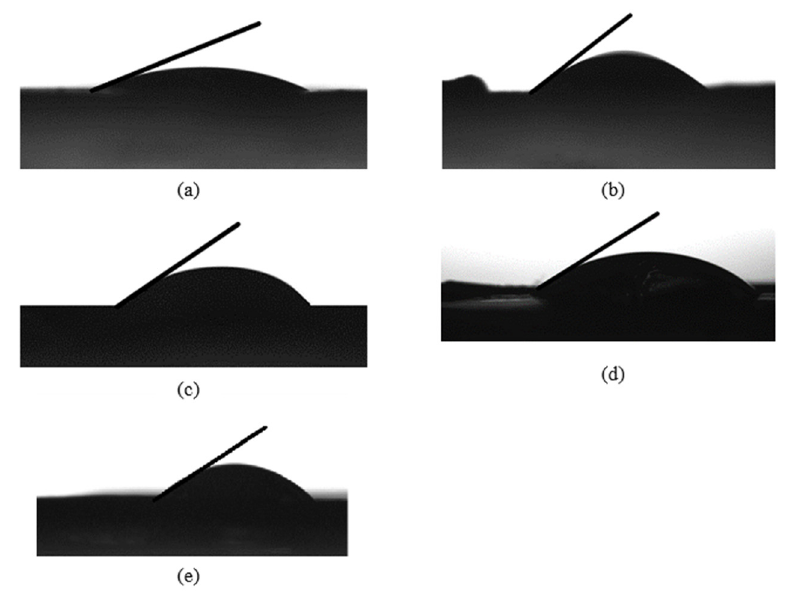
9 of 18 Figure 6. XRD pattern of film of CCMC ( a ) and OCMC ( b ). 2.6. Contact Angle and Tensile Strength Measurement Contact angle measurement can be used to determine the hydrophilicity and hydrophobicity of CMC film as shown in Figure 7. It was notable that CMC produced with 20% NaOH was unable to be used for the preparation of the stable and intact film.